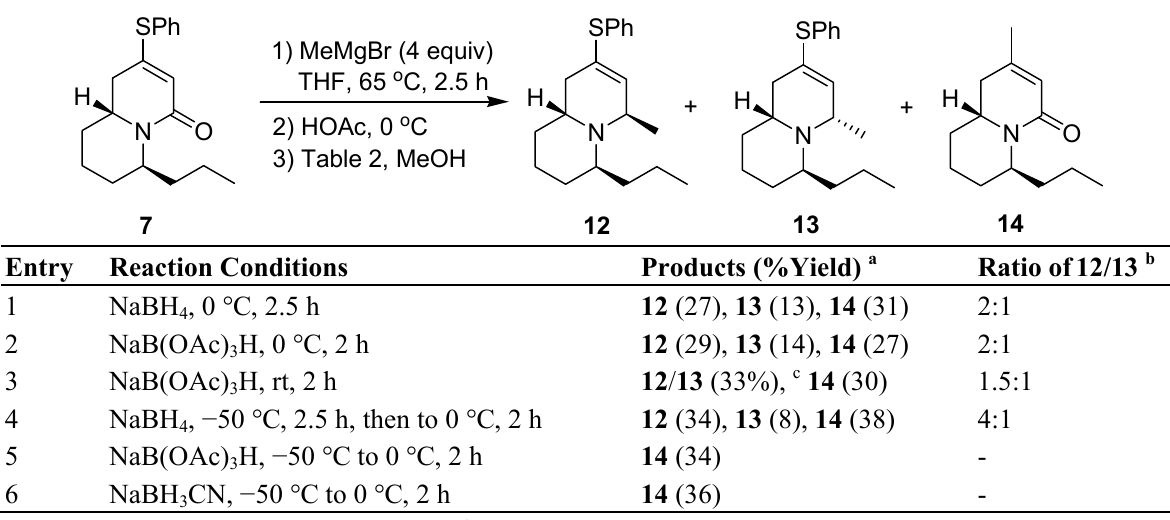
Table 2. Reactions of compound 7 with MeMgBr followed by